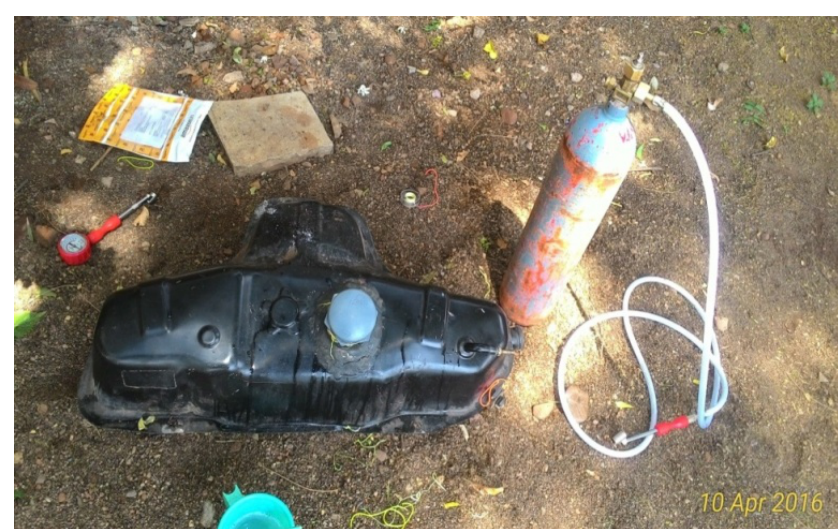
Fig. 4. Carbonation Chamber